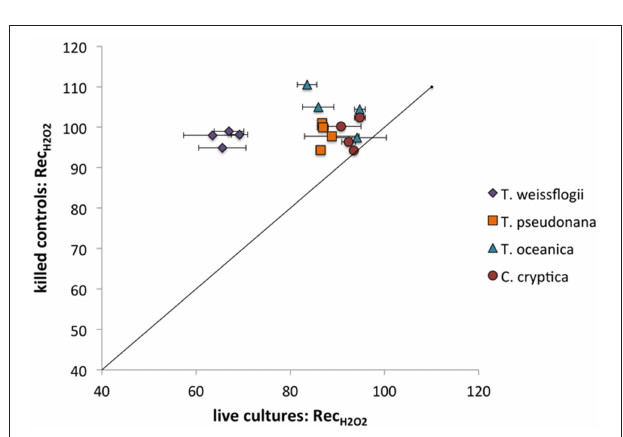
FIGURE 6 | H 2 O 2 recovery percentages for live vs. killed organisms for T. weissflogii , T. pseudonana , T. oceanica , and C. cryptica . The line represents a 1:1